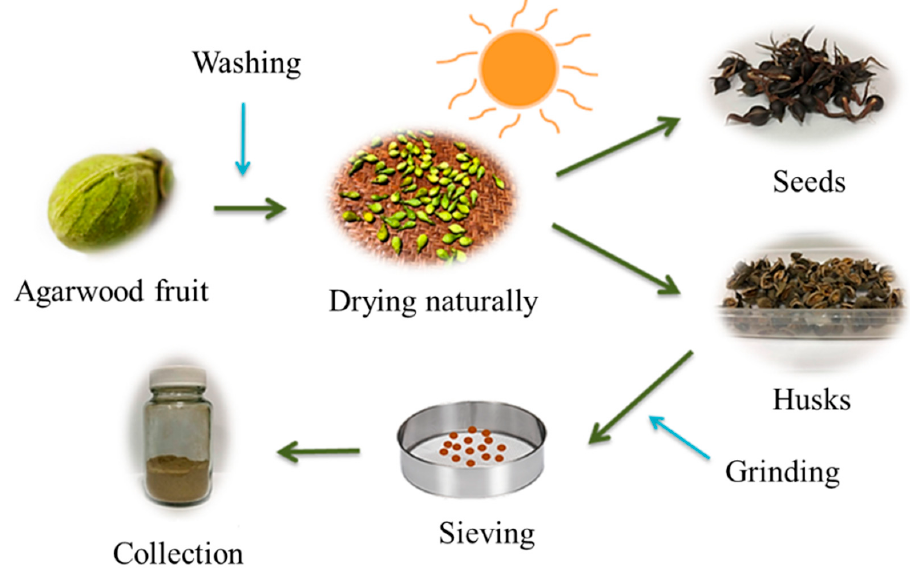
Figure 13. The treatment process of agarwood